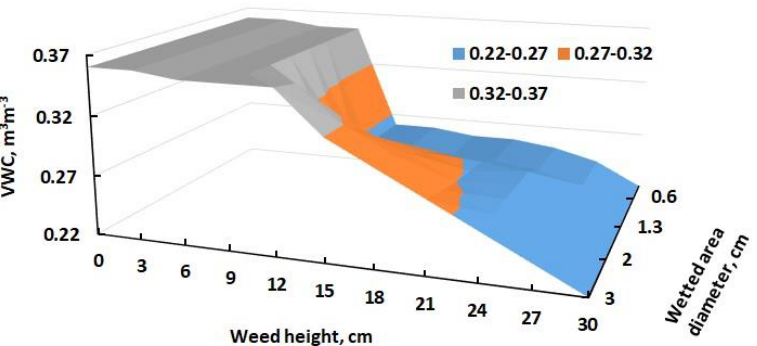
Figure 20. Effect of weed height in soil volumetric water content and diameter moistened by the micro-sprinklers. Mature trees during the 2020 and 2021 seasons received different quantities of water, changing specially during 2021 with the use of the fuzzy controller. Water applied by the irrigation system during 2021 stopped with rainwater. Each tree received four times more water during 2020 than 2021, Table 9. Fruit per tree was higher in 2021, than in 2020 due to the higher precipitation and reduced foliage. In both years, lower quantities of fruits and heavier produce were obtained with the RDI-2 50% treatment. A higher fruit yield of 5.4% was produced in 2021 when compared with the 2020 harvest both using the 100% DI treatment. The increase in production was attributed to tree pruning and greater precipitation. Average fruit weight and yield obtained during 2021 is compared in Tables 6 and 9, to see the effect of employing the fuzzy controller. In both 75% and 100% irrigation treatments a higher fruit yield was recorded with the fuzzy controller. In both cases, the pruning effect and rainfall differences were ruled out. Yield increases resulted from the use of the fuzzy controller, as excessive water application was avoided. Table 9. Average fruit yield, fruit per tree, fruit weight, water applied, canopy volume and WUE for each irrigation treatment in 2020 and with the fuzzy controller during 2021 in high-density trees.